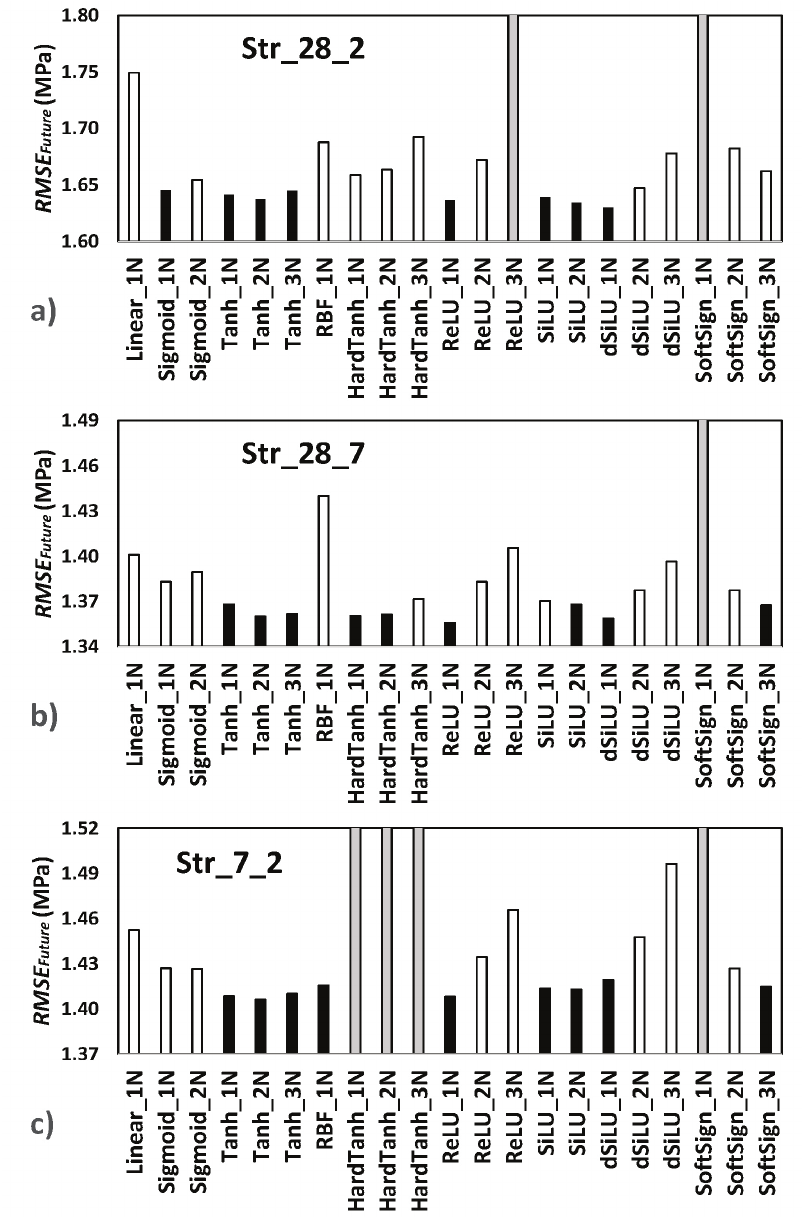
Fig. 11 – Optimum errors for all the ANNs’ architectures and AFs for a) Str_28_2, b) Str_28_7, and c) Str_7_2